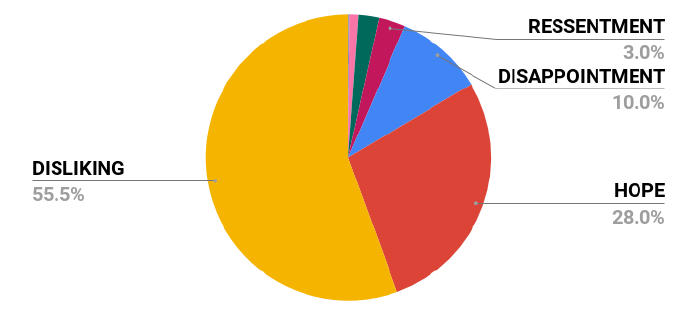
Figure 21. Inferred emotions in module